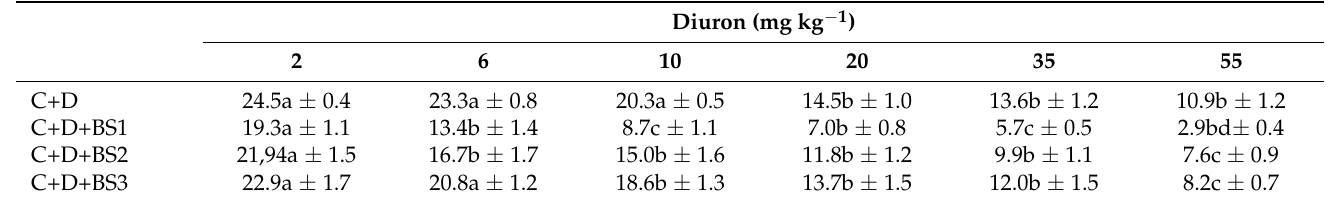
Table 6. Evolution of diuron (mean ± standard error, n = 3) in soils during the incubation